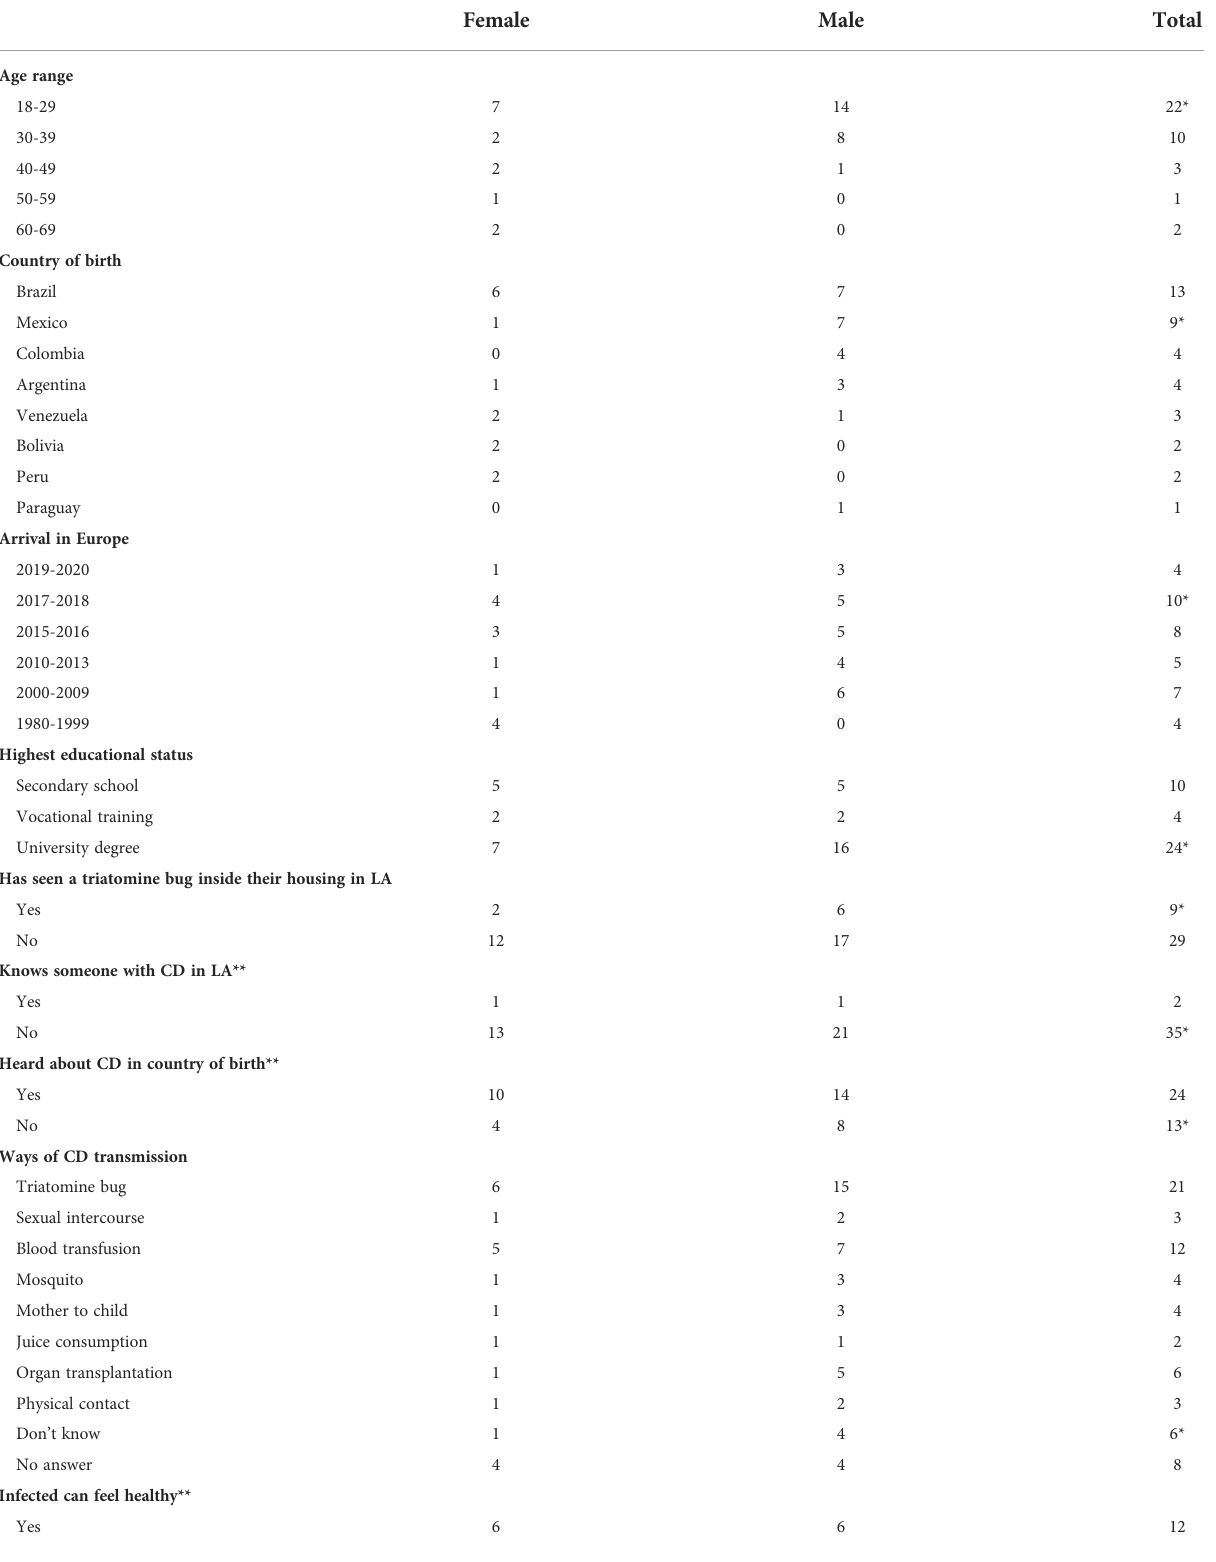
TABLE 2 Questionnaire data of prospective study